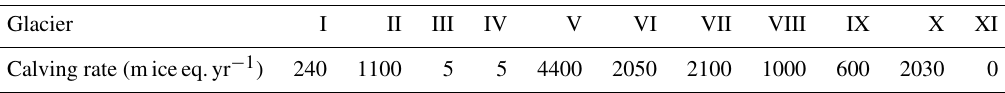
Table 3. Calving rates applied at the 11 outlet glaciers where terminus migration is simulated and ocean melt parameterized. Each Roman numeral is associated with a corresponding glacier, shown in Fig. 3. Total frontal ablation results from both calving and melt at the terminus, which is governed by basin-specific TF values given in Table 2.